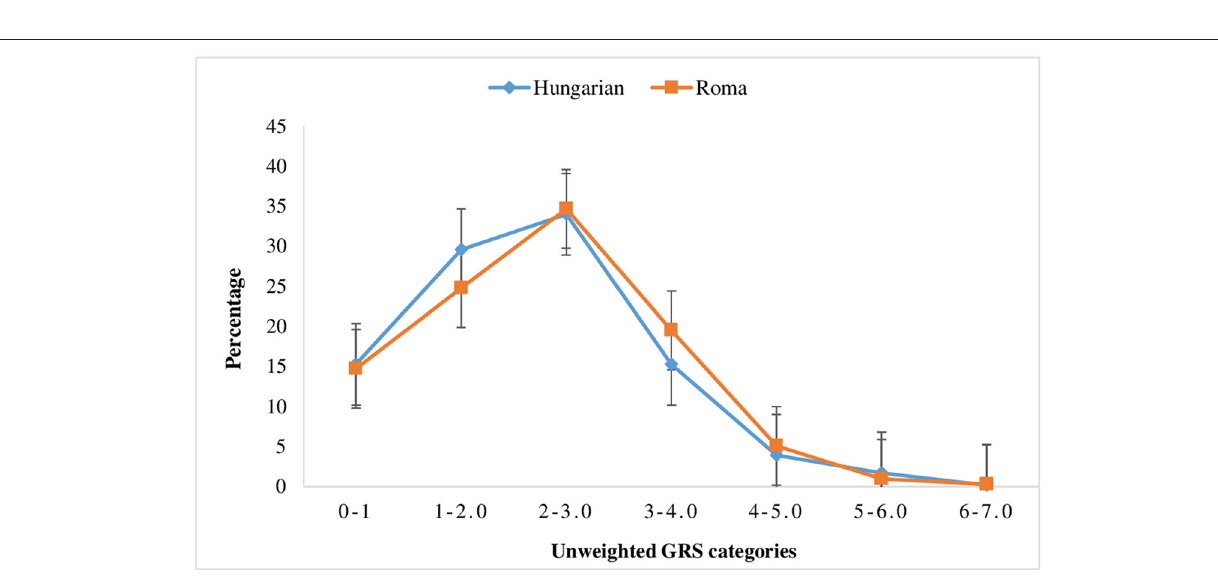
95% CI: [1.23, 28.4]). Furthermore, people with the